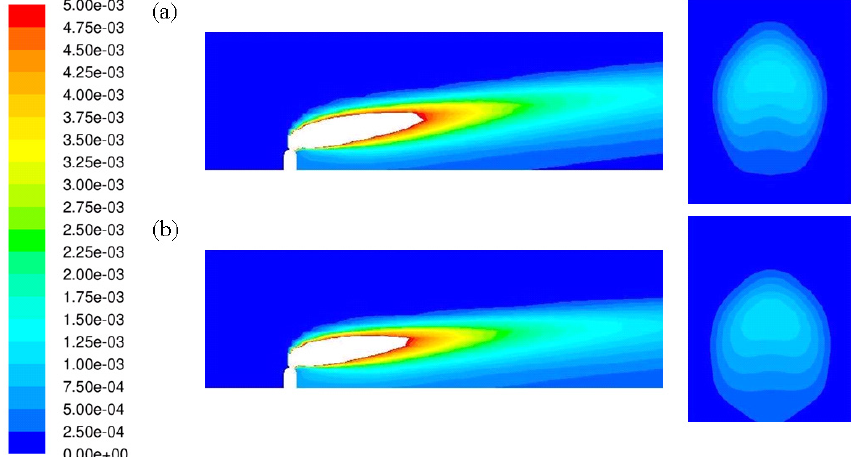
Fig. 8. Projections of 3-D pollutant concentration field: (a) constant velocity of the ambient flow: V = 0 . 15ms − 1 (b) logarithmic BBL profile V (y) = 0 . 144+0.033 ln(y)ms. Longitudinal view: vertical cross section passing through the port center (x=2.5m) and transversal view at a z-distance of 22m from the port. The unit of concentration is wt